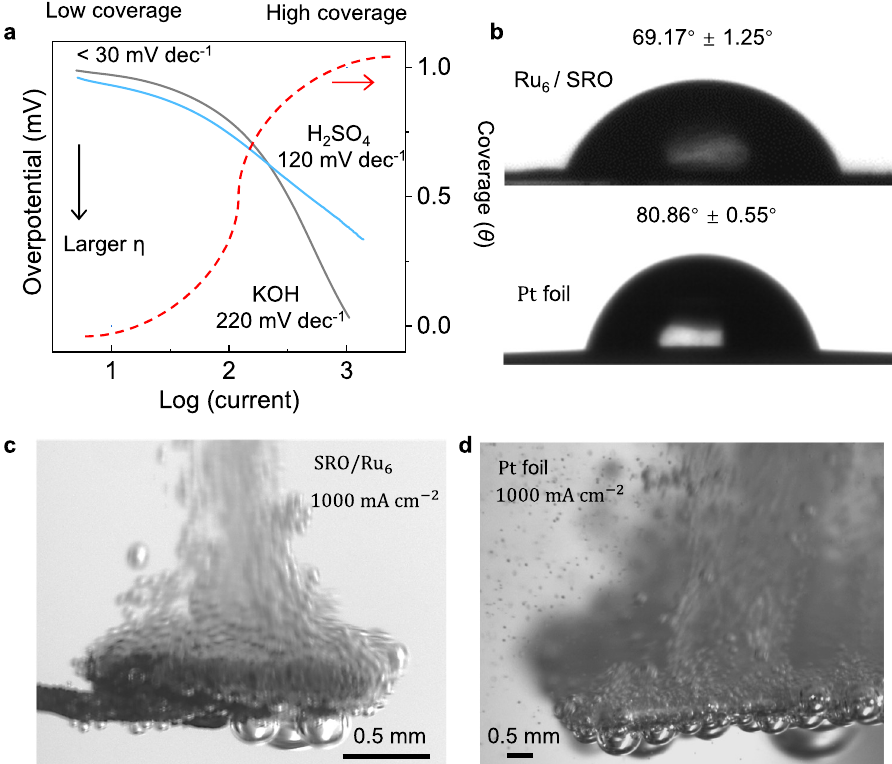
Fig. 5 | Mechanism of the HER process at large current densities. a . Tafel slope analysis of the Ru 6 /SRO catalyst under high current densities. The red dotted line shows the coverage-dependent current densities. b . Water contact angles of